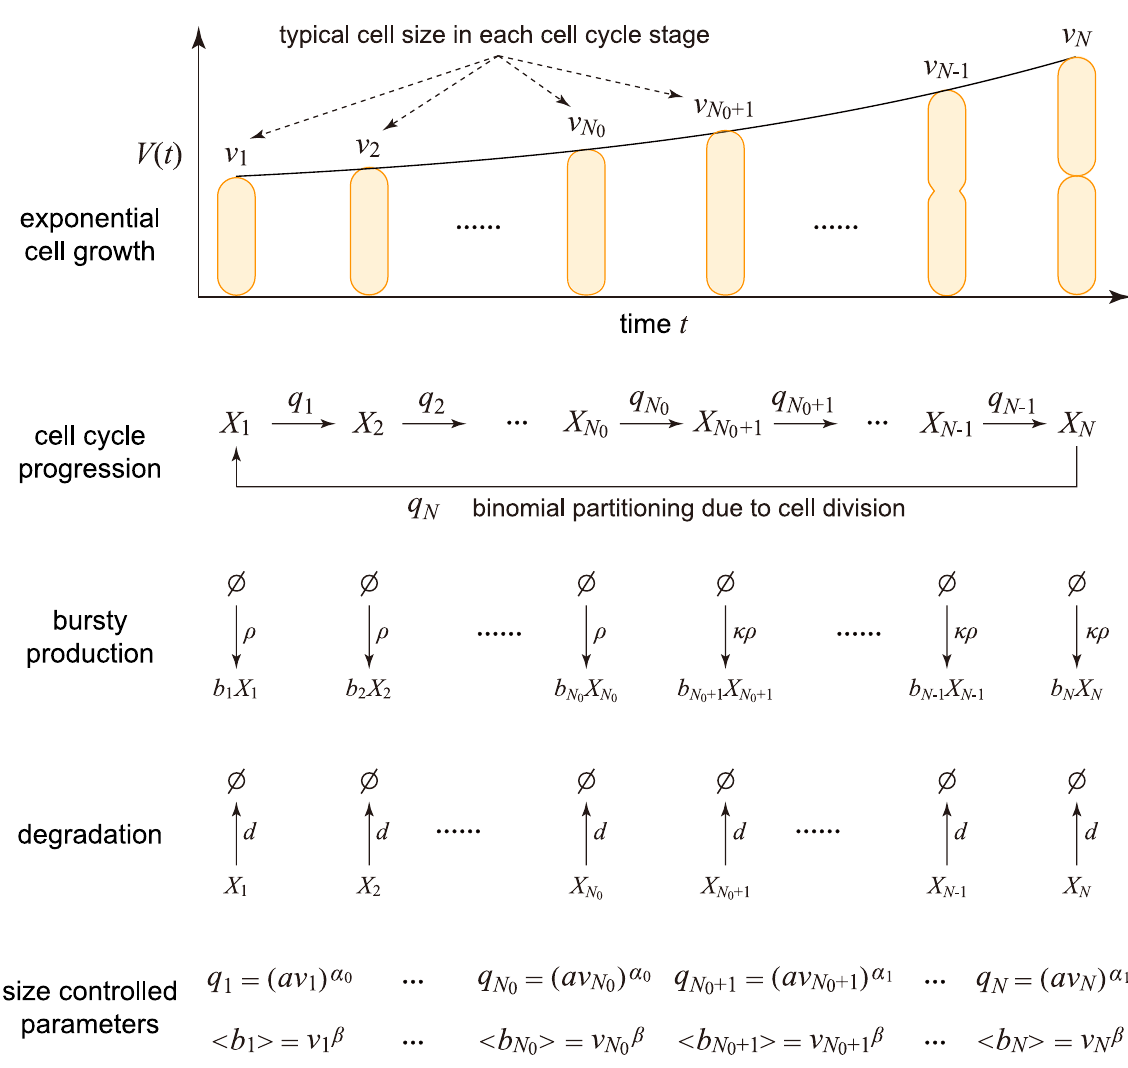
denotes the gene product at stage k k